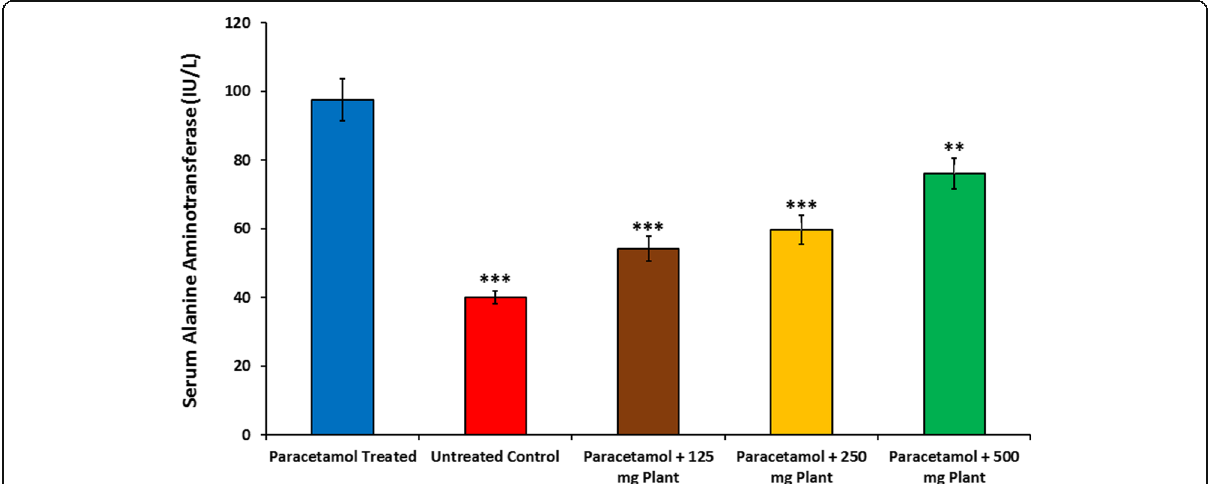
Fig. 1 Bar charts showing the effect of A. orientalis on liver function markers, serum ALT in paracetamol treated, untreated control, paracetamol A. orientalis pretreated 125, 250, 500 mg/kg BW mice groups. Note that in all doses ALT levels were significantly reduced compared to paracetamol treated mice group. Data are presented as: mean ± SEM, n = 6, ** or *** P < 0.05 showed moderate or sever significant difference, respectively